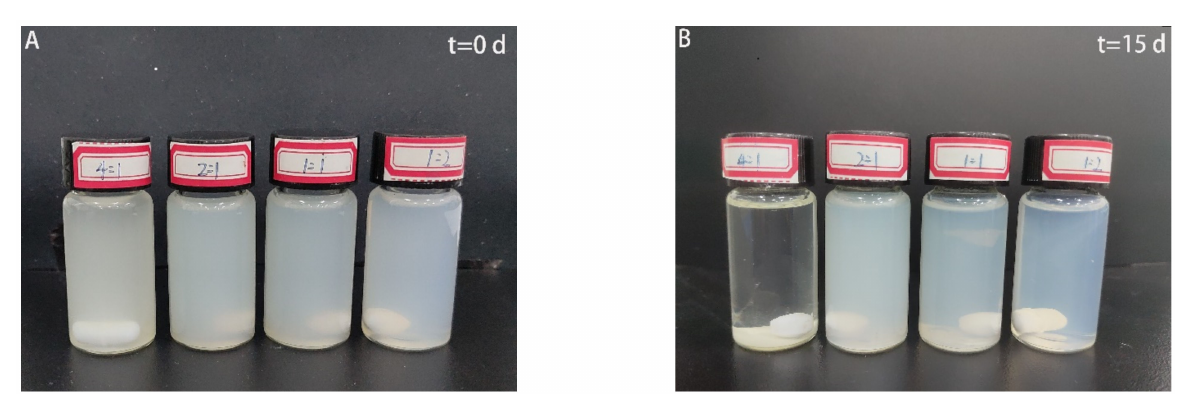
Figure 5. Photographs of CA-loaded nanoparticles with zein/SC mass ratios of 4:1, 2:1, 1:1, and 1:2. ( A ) Freshly prepared. ( B ) Standing after 15 storage